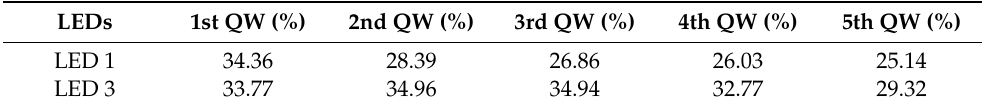
Table 3. Values of the electron and hole wave function spatial overlap levels in the active region for LED 1 and LED